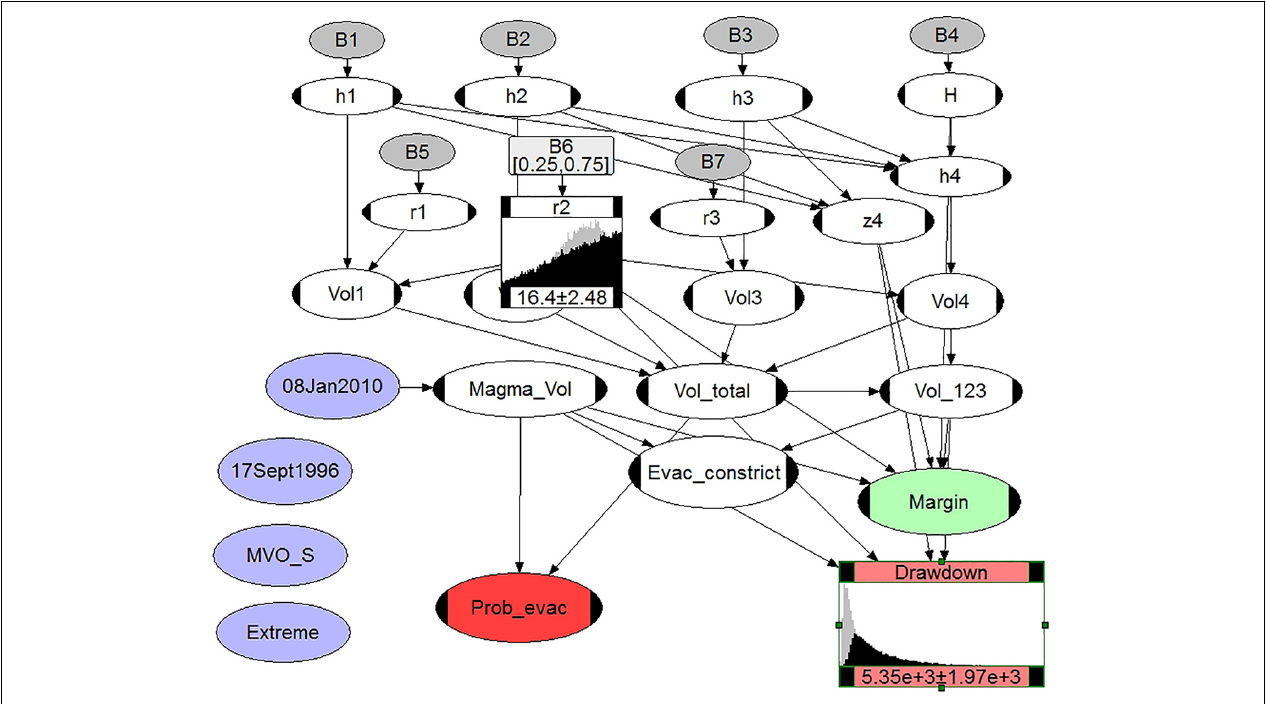
FIGURE 6 | The January 8, 2010 explosion BBN with conduit radius r 2 conditionalized to a range of values in the center of its uncertainty spread and resulting revised distribution for Drawdown node. Prior distributions are shown as light gray histograms (see